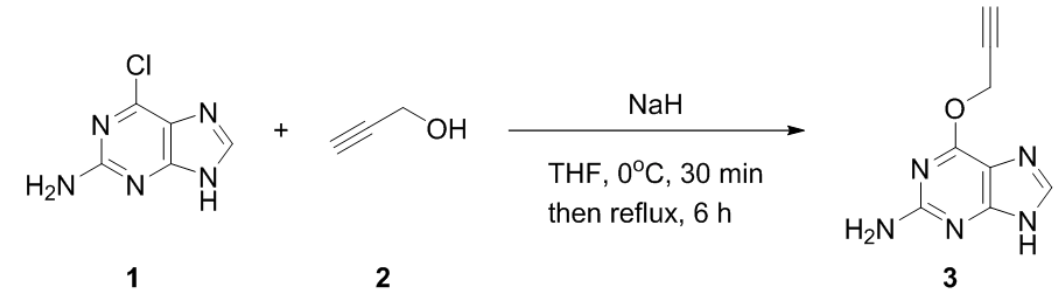
15 of 19 Figure 8. MGMT lifecycle in cancer cells. Figure key: PO 4 —phosphate group; -SH—thiol group of Cys145 in MGMT; -SX—inactivated MGMT; P’ase—phosphatase; U—ubiquitin. Phosphorylation of active MGMT functionally inactivates it. Active MGMT can be regenerated by the action of intracellular phosphatases. MGMT can also be inactivated by its actions to remove DNA O 6 -adducts (functional inactivation) or by reaction with reactive oxygen species or other cellular electrophiles (futile inactivation). Inactive MGMT is ubiquitinated and is transported for degradation in lysosomes. 4. Materials and Methods Amino-PEG 5000 -azide trifluoroacetate salt was obtained from JenKem Technologies, China. All other reagents were obtained from Sigma-Aldrich, USA, and used without further purification. Mass spectra were determined on a Thermo-Scientific LCQ FLEET spectrometer in electron impact (EI) mode. Proton ( 1 H) and carbon ( 13 C) nuclear magnetic resonance (NMR) spectra were recorded at